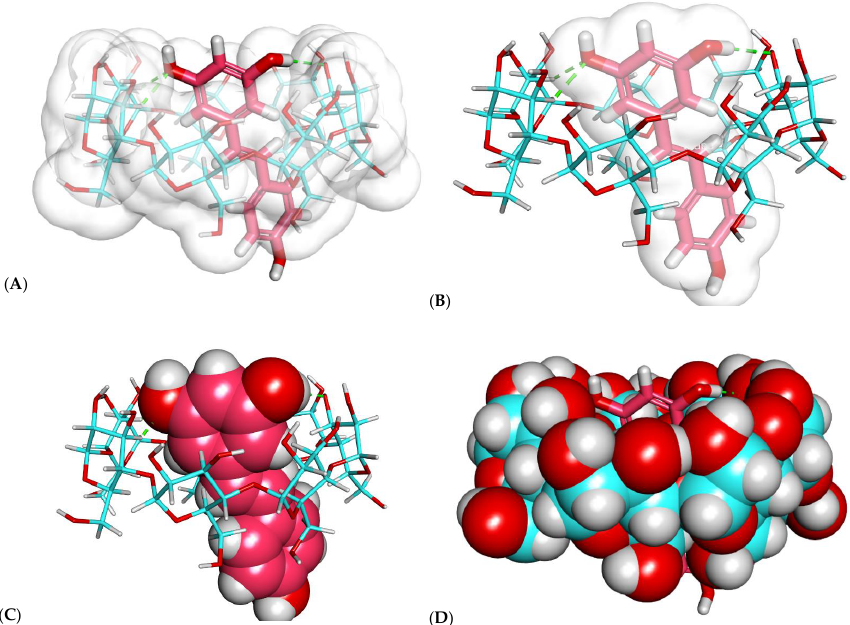
Figure 2. Docked poses of the best-ranked docking score of resveratrol with β -CD (front view): ( A ) resveratrol (sticks) and β -CD (sticks) pointing at β -CD, ( B ) resveratrol (sticks) and β -CD (sticks) pointing at resveratrol, ( C ) resveratrol (CPK) and β -CD (sticks), ( D ) resveratrol (sticks) and β -CD (CPK).